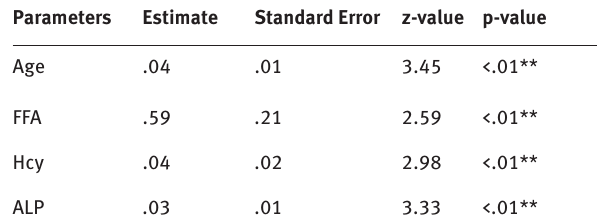
Table 3: Multivariate Logistics Regression of Prognosis